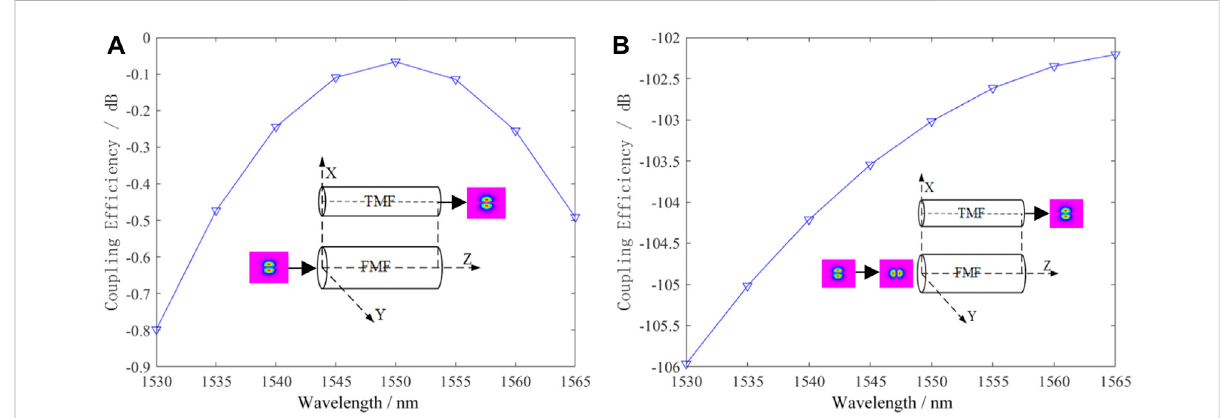
FIGURE 1 Mode rotation during the mode transmission leads to (A) the best coupling case with rotation angle of ± k π , k (cid:1) 0 , 1 , 2 , ... , .) versus (B) the ± k π , k (cid:1) 0 , 1 , 2 , ... , worst coupling case with π 2